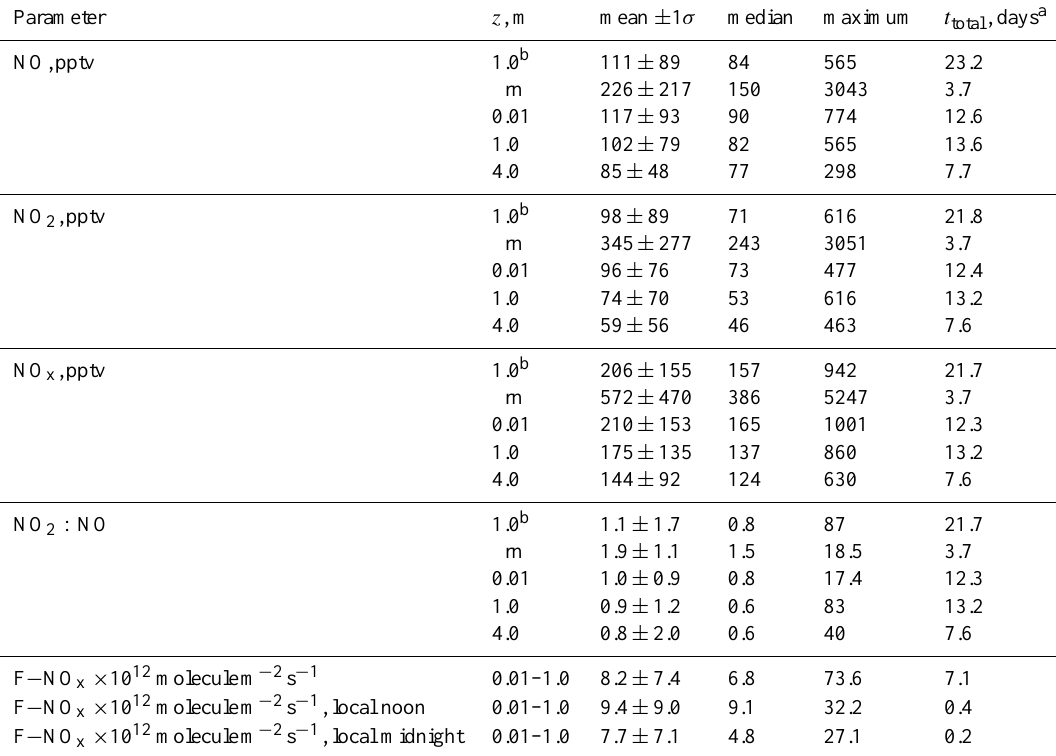
Table 2. NO x mixing ratios and flux at Dome C during 22 December 2009–28 January 2010.